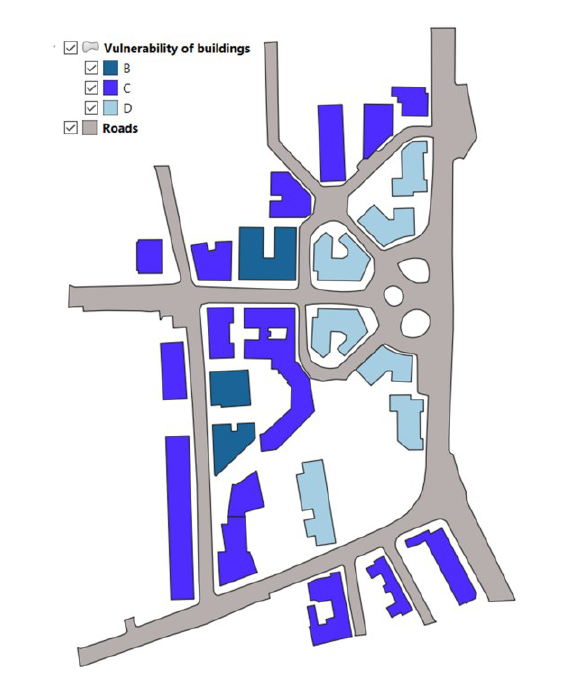
Figure 8. The vulnerability classes of